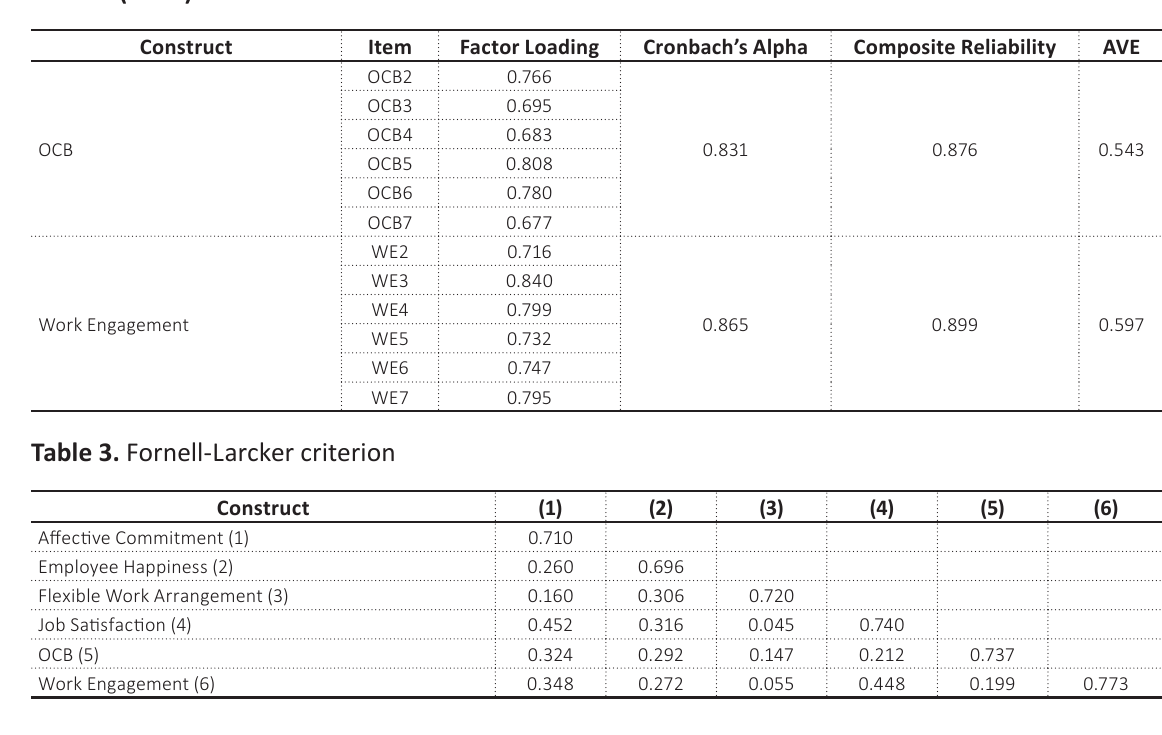
Table 2 (cont.). Measurement mode